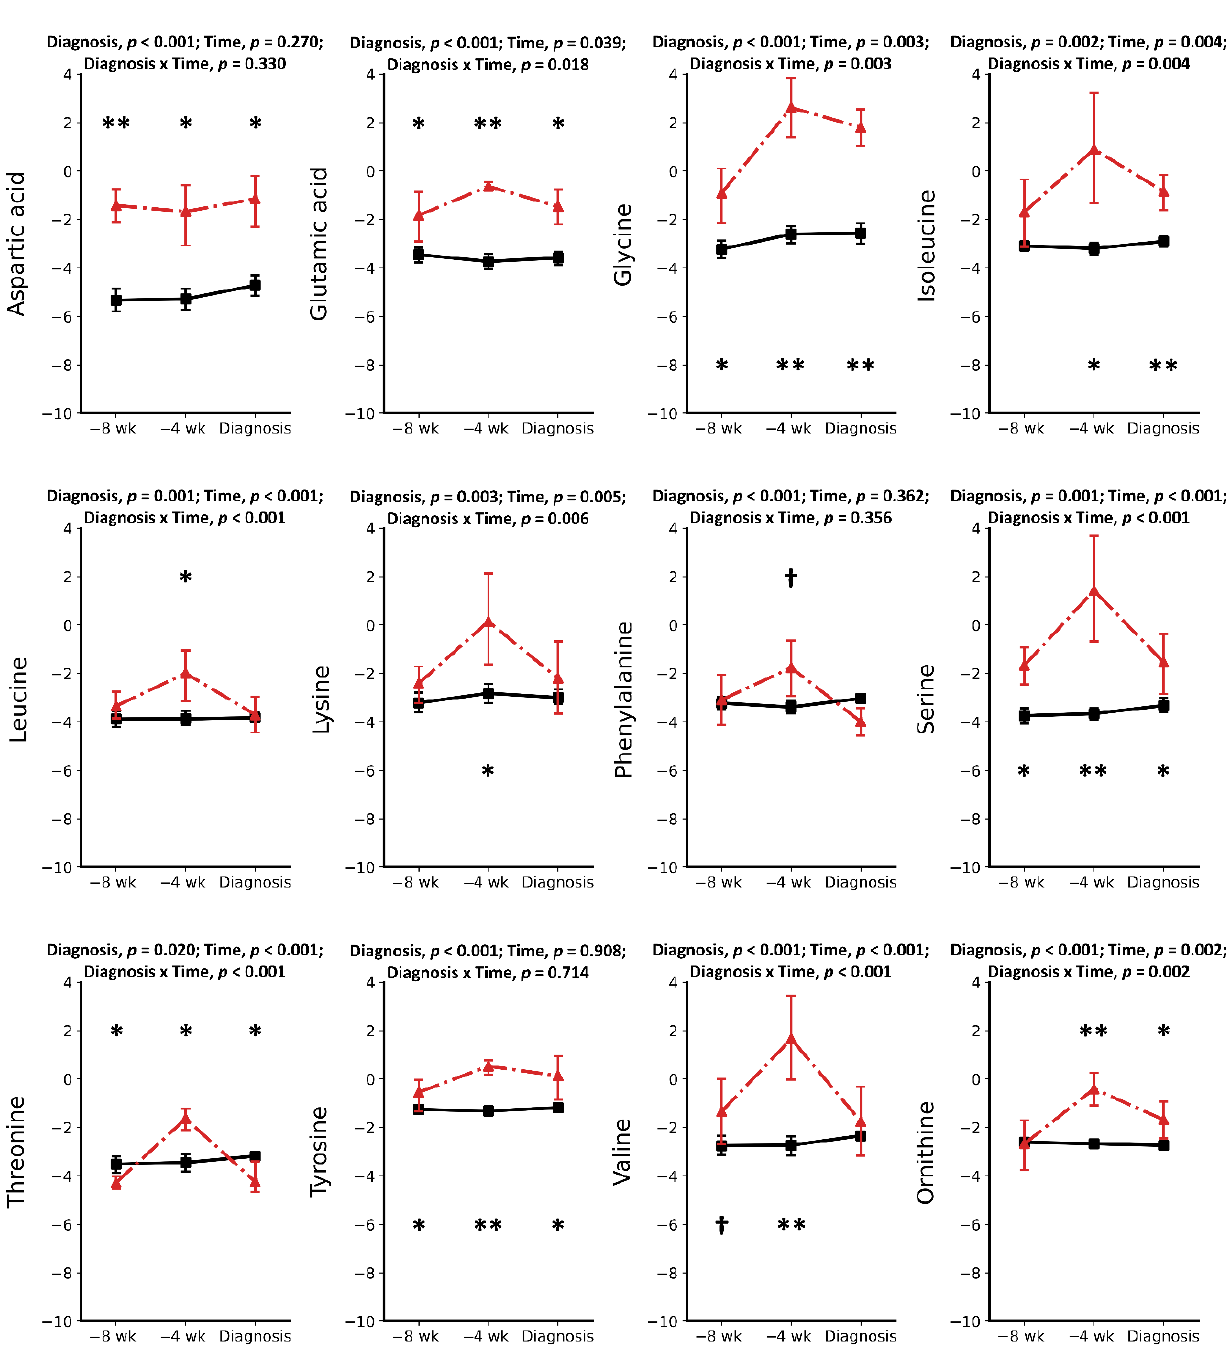
Figure 1. Concentrations of amino acids in the serum of healthy cows (solid line) and pre-retained placenta or retained placenta (dashed line) cows at −8 and −4 weeks prepartum or at the week of retained placenta diagnosis. Asterisks († p < 0.1; * p < 0.05; ** p < 0.001) indicate significant differences between groups at the respective time points. Results are presented in log2.